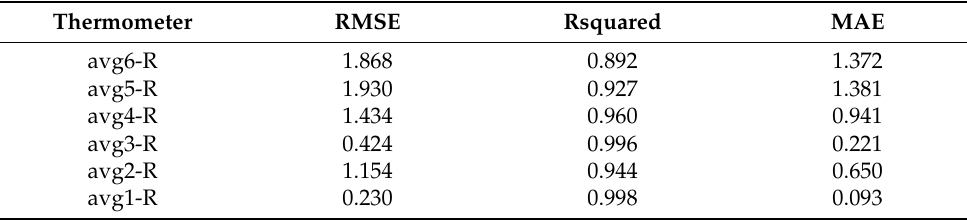
Table 11. Predicting accuracy for water temperature